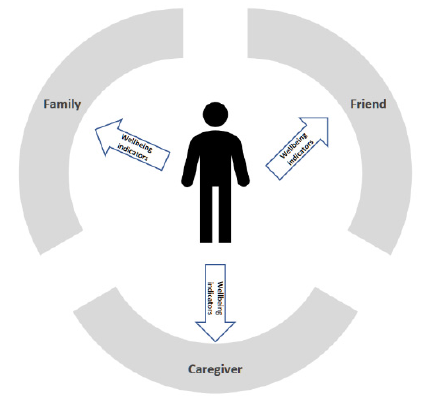
Figure 4. User circle.